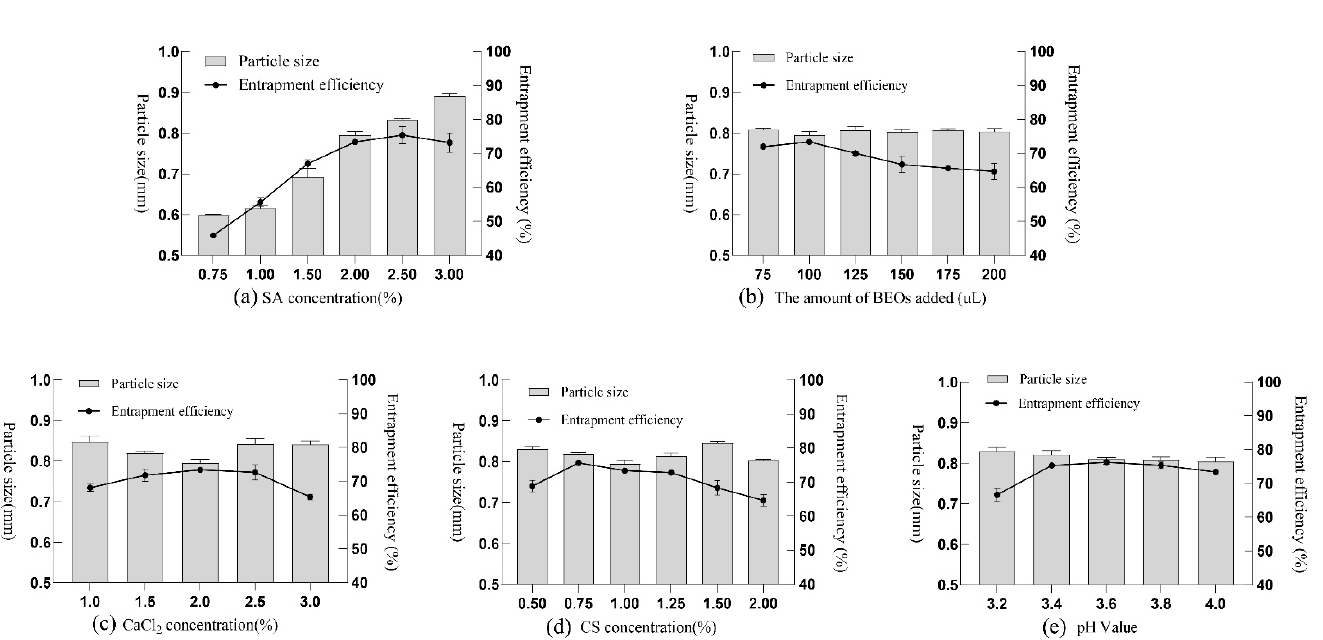
Figure 1. Effect of various factors on microcapsule diameter and EE. ( a ): Sodium alginate concentra- tion; ( b ): The amount of BEO added; ( c ): CaCl 2 concentration; ( d ): Chitosan concentration; ( e ): pH